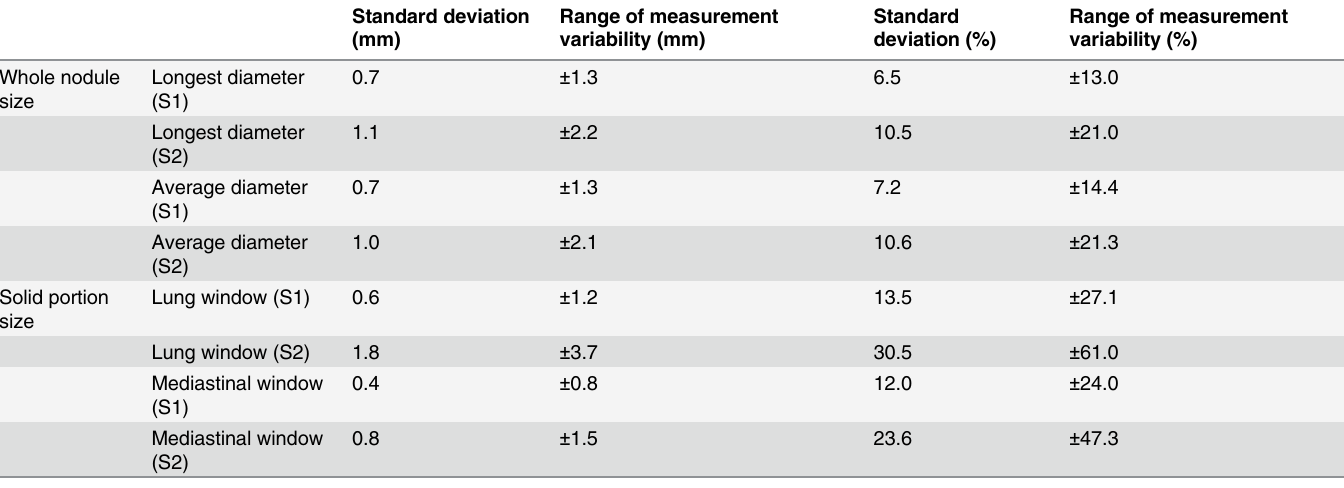
Table 1. Measurement variability of whole nodules and solid portion size on follow-up CT